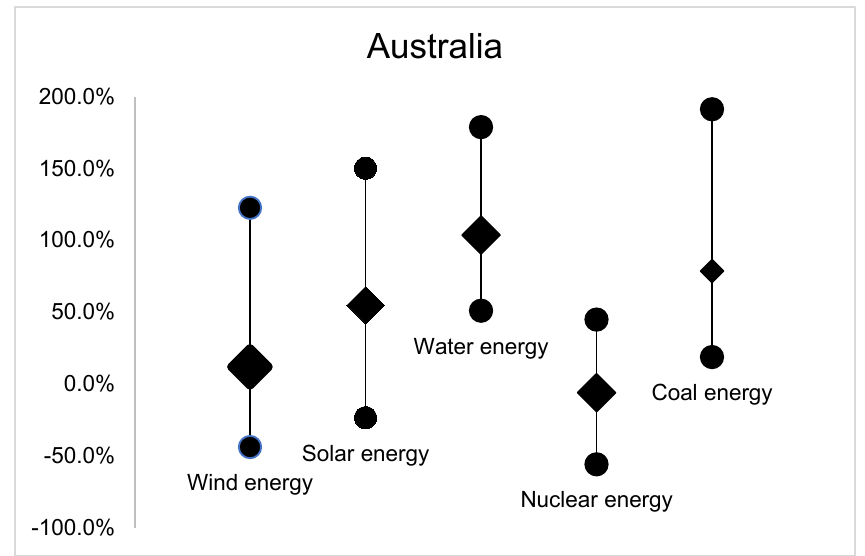
Figure 11. Willingness to pay for various types of electric energy in Australia . Source: own study. Figure 12 represents Canadian customers’ preferences and their WTP by energy type.